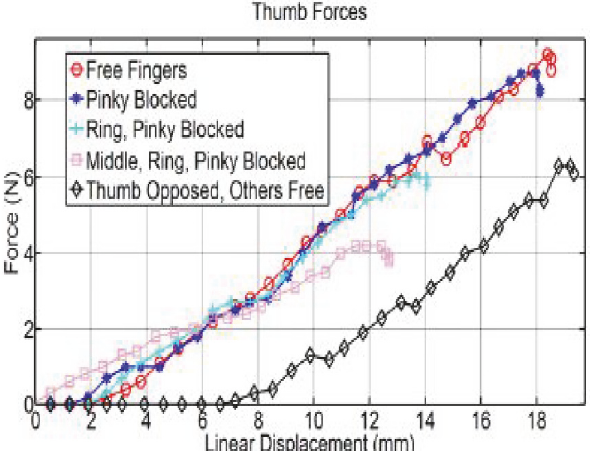
Figure 14: Object grasping at 200g.